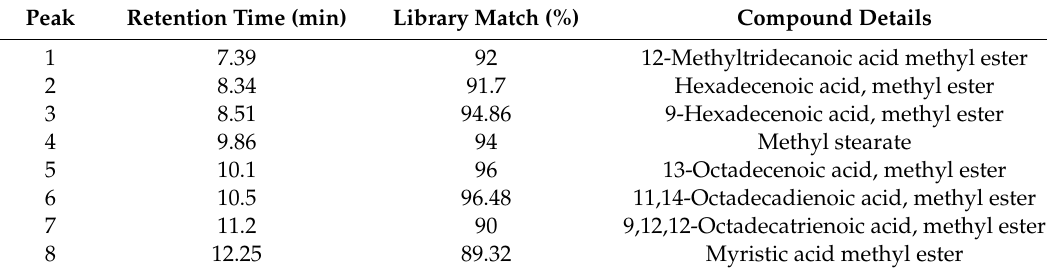
Figure 5. Illustrates the gas chromatography with mass spectrometry (GC-MS) spectrum of biodiesel obtained after transesterification with TiO 2 -0.5Li. Table 4. The biodiesel profile attained after transesterification with TiO 2 -0.5Li.